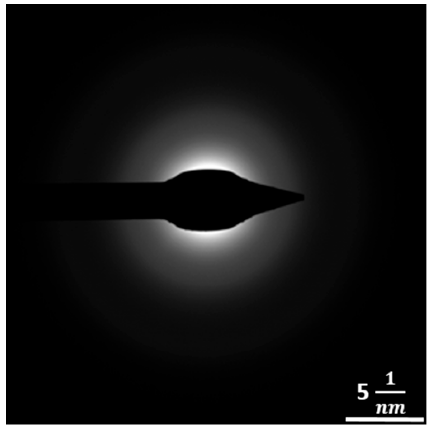
Figure A2. SAED pattern of virgin anthracene coke.